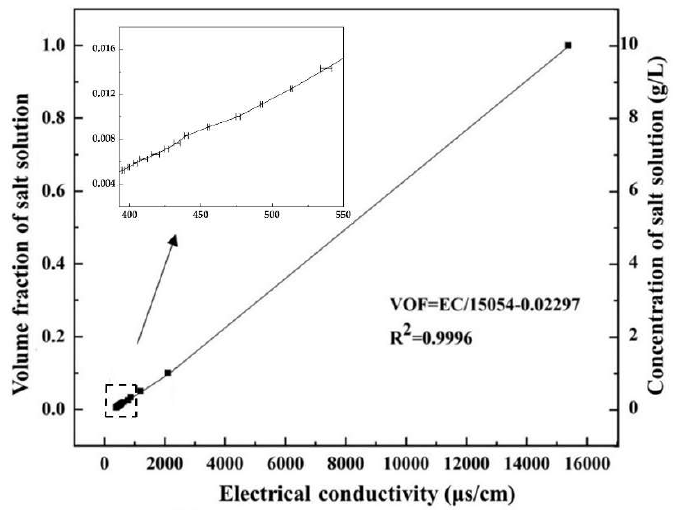
Figure 5. Relationship among electrical conductivity (EC), volume fraction (VOF), and concentration (C) of salt solution.